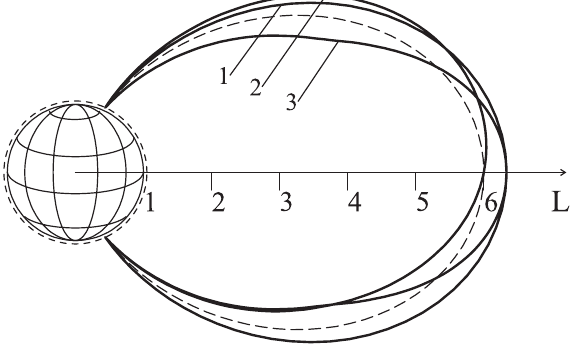
Fig. 2. The structure of the first three harmonics of standing Alfv´en waves (bold lines) on the magnetic shell L = 6 (dashed line).